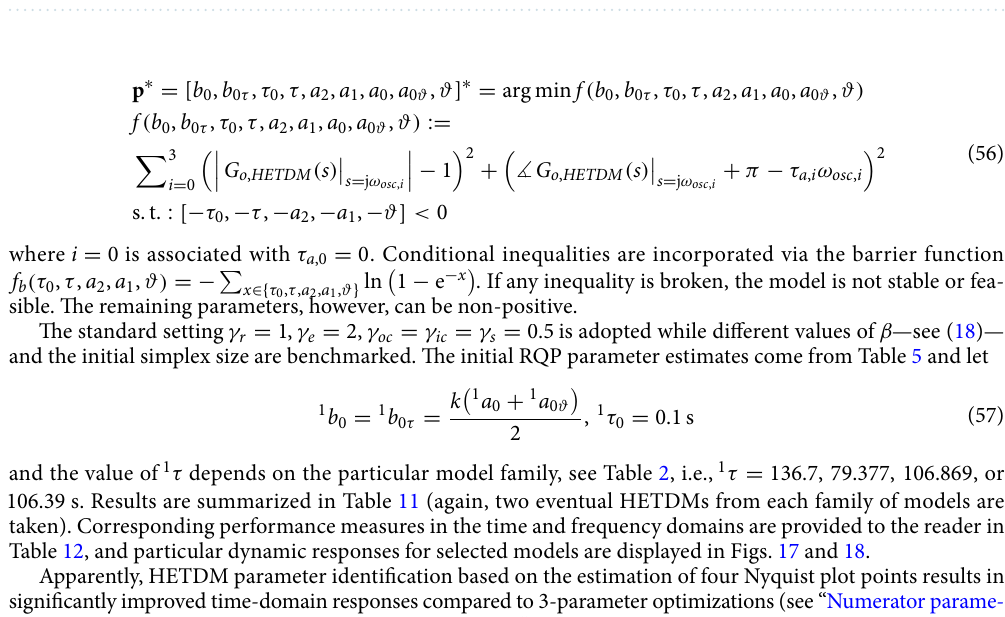
Figure 16. Relay experiment responses (with artificial